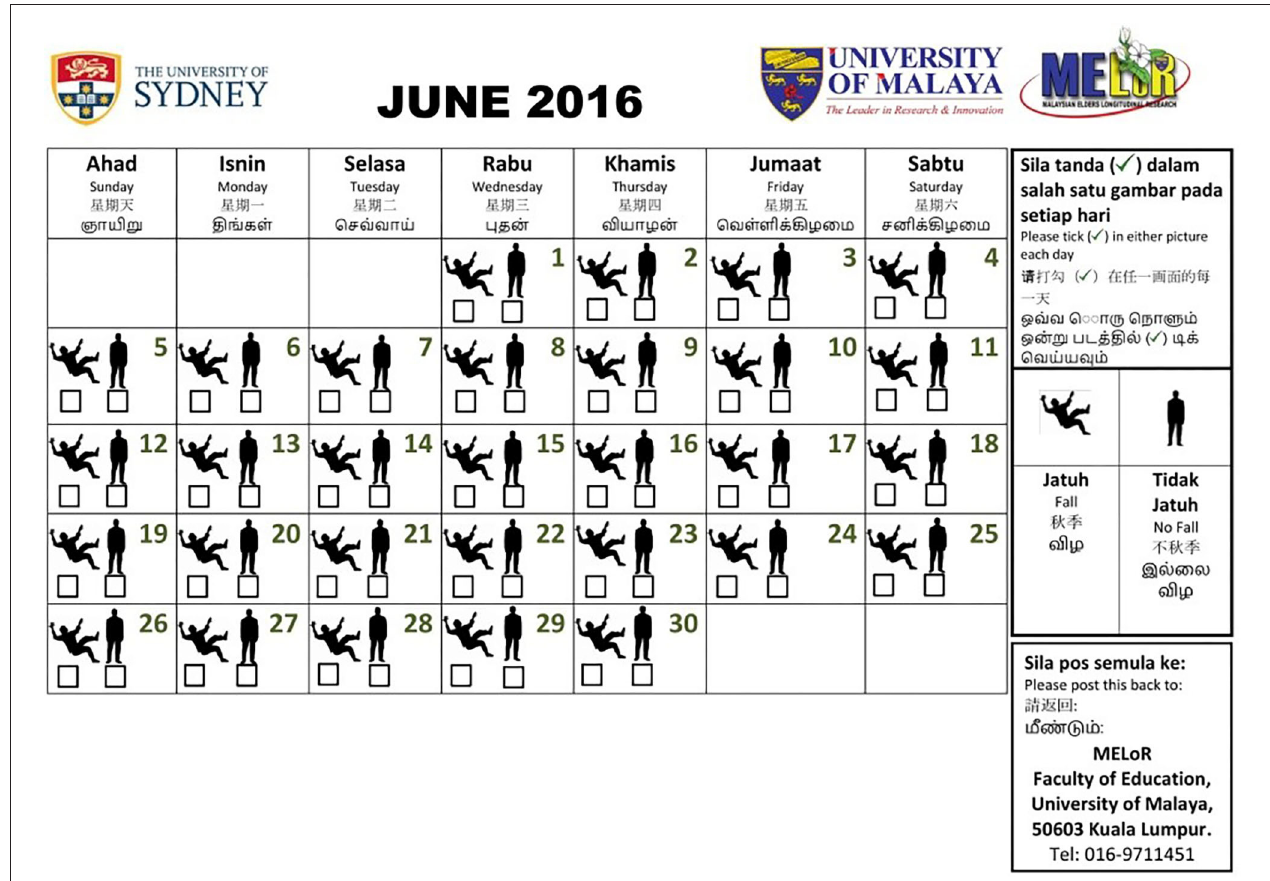
FIGURE 2 | A sample of the falls calendar used in the Malaysian Elders Longitudinal Research (MELoR) study. A 1-month-to-a-page desktop calendar was posted to selected participants. The calendar prompted daily tick-box entries below a falling or standing silhouette indicating the presence and absence of a fall. The instructions were available in four common languages within the page, alongside contact details and the return